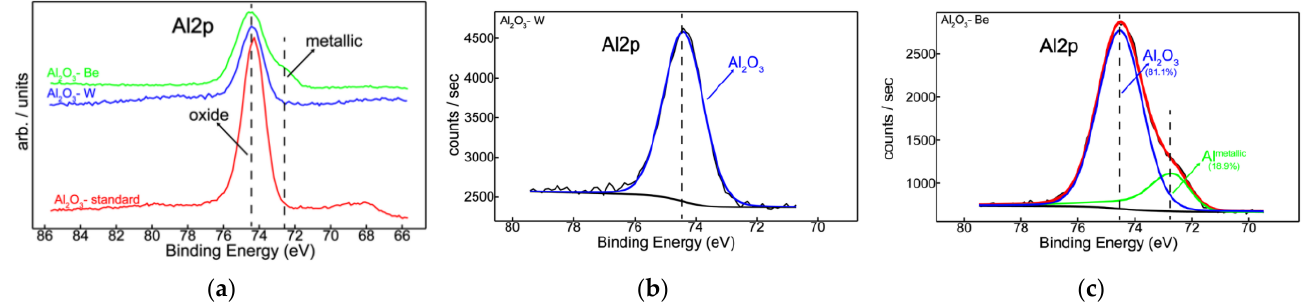
Figure 5. Al2p XPS superimposed spectra for the three stages of the Al system ( a ); Al2p XPS peak-fitted spectrum for Al 2 O 3 -W system suggesting constant chemical behavior on the higher binding energy side of the Al2p photoemission peak ( b ); Al2p XPS peak-fitted spectrum for Al 2 O 3 -Be system identifying the occurrence of metallic aluminum ( c ). For a general overview of the chemistry of aluminum and erbium within the pre- pared configurations, Al2p and Er4d spectra were superimposed for each sample (Figures 5a and 6).